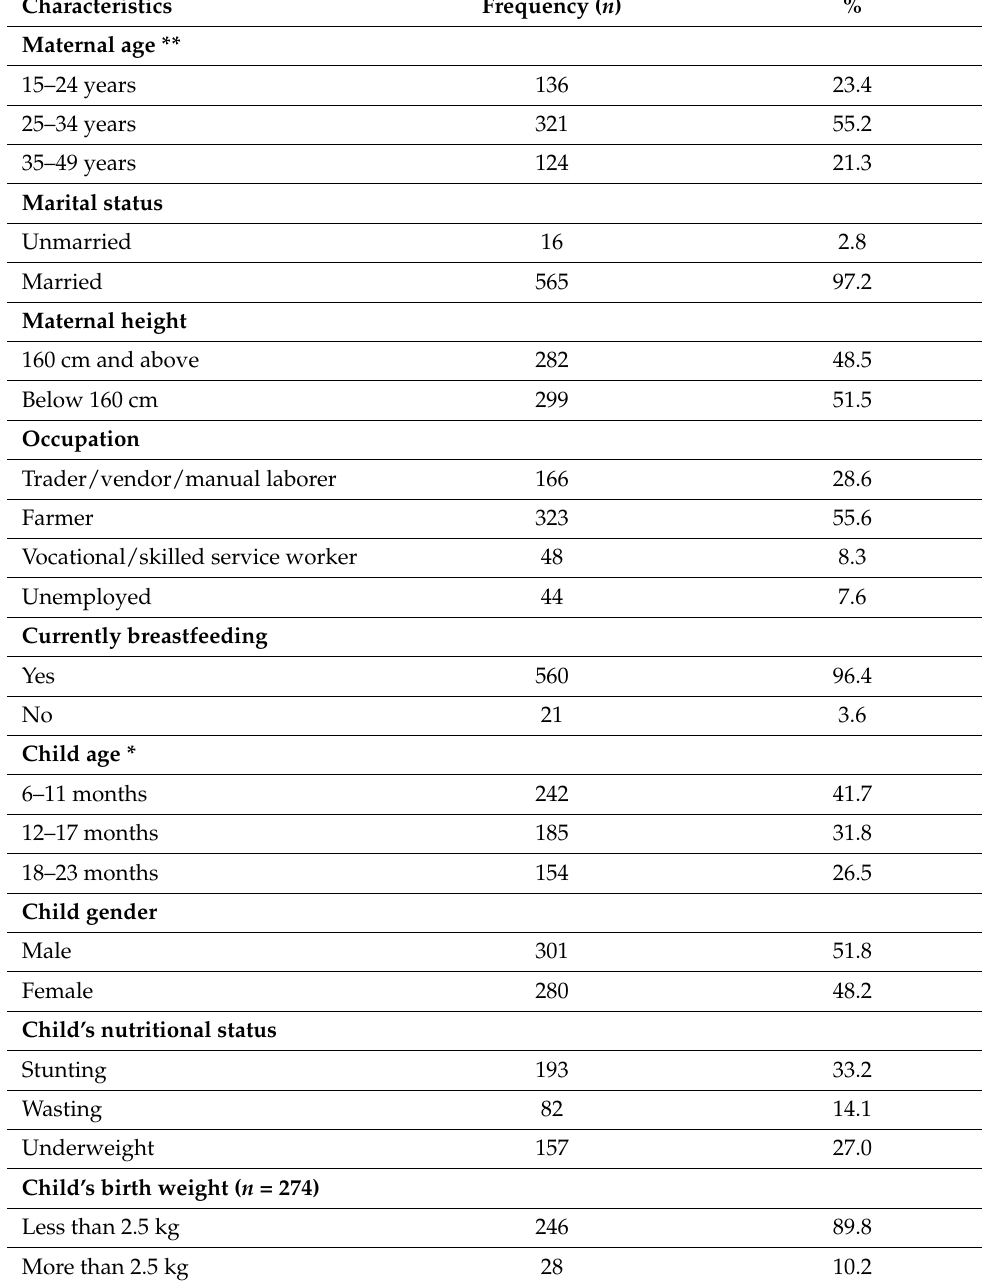
Table 3. Maternal and child characteristics ( n =